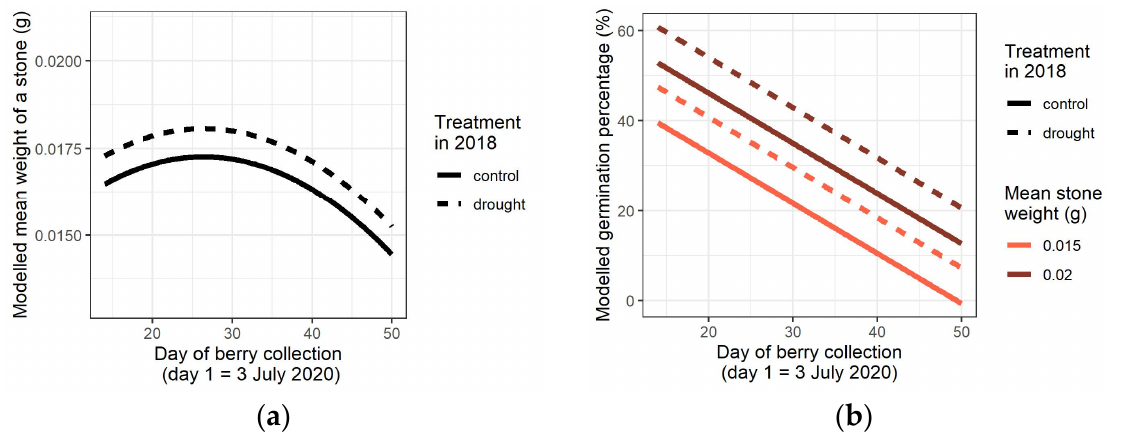
Figure 4. Modelled mean weight of a stone, according to the treatment in 2018 and to the day of berry collection in 2020 ( a ) and modelled germination percentage according to the treatment in 2018, to the day of berry collection in 2020 and to the mean stone weight ( b ).